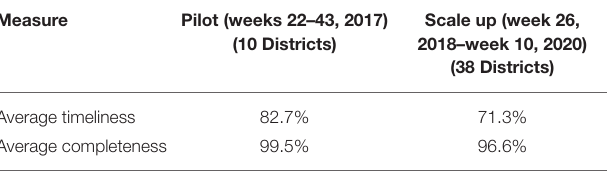
TABLE 5 | Average timeliness and completeness of aggregate disease surveillance reports in DHIS2 during pilot and scale up phases.